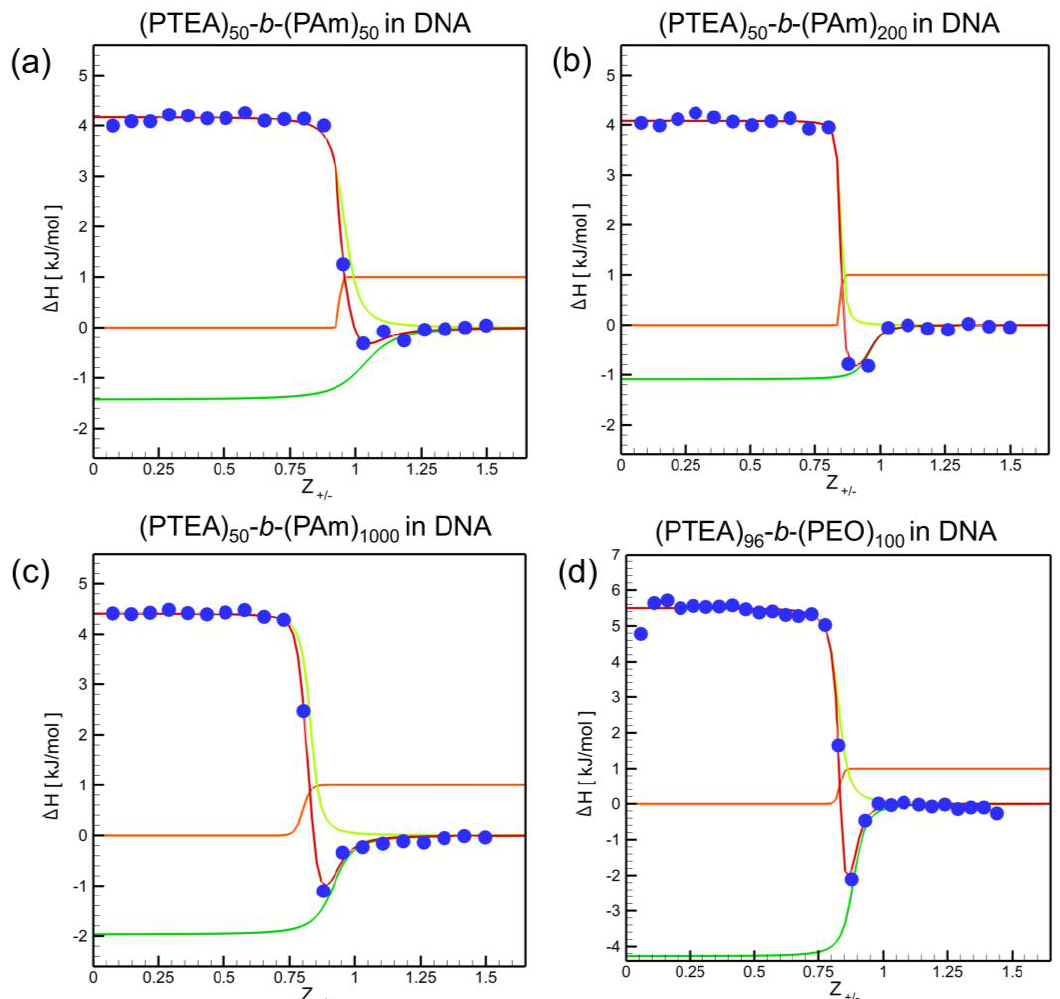
Figure 1. Binding enthalpy for titration ( a ) PTEA 50 - b -PAm 50 , ( b ) PTEA 50 - b -PAm 200 , ( c ) PTEA 50 - b -PAm 1000 , and ( d ) PTEA 96 - Figure 1. Bindingenthalpyfortitration( a )PTEA 50 - b -PAm 50 , ( b )PTEA 50 - b -PAm 200 , ( c ) PTEA 50 - b -PAm 1000 , b -PEO 100 with DNA, as a function of their charge ratios (Z +/- ). and ( d ) PTEA 96 - b -PEO 100 with DNA, as a function of their charge ratios (Z +/ −